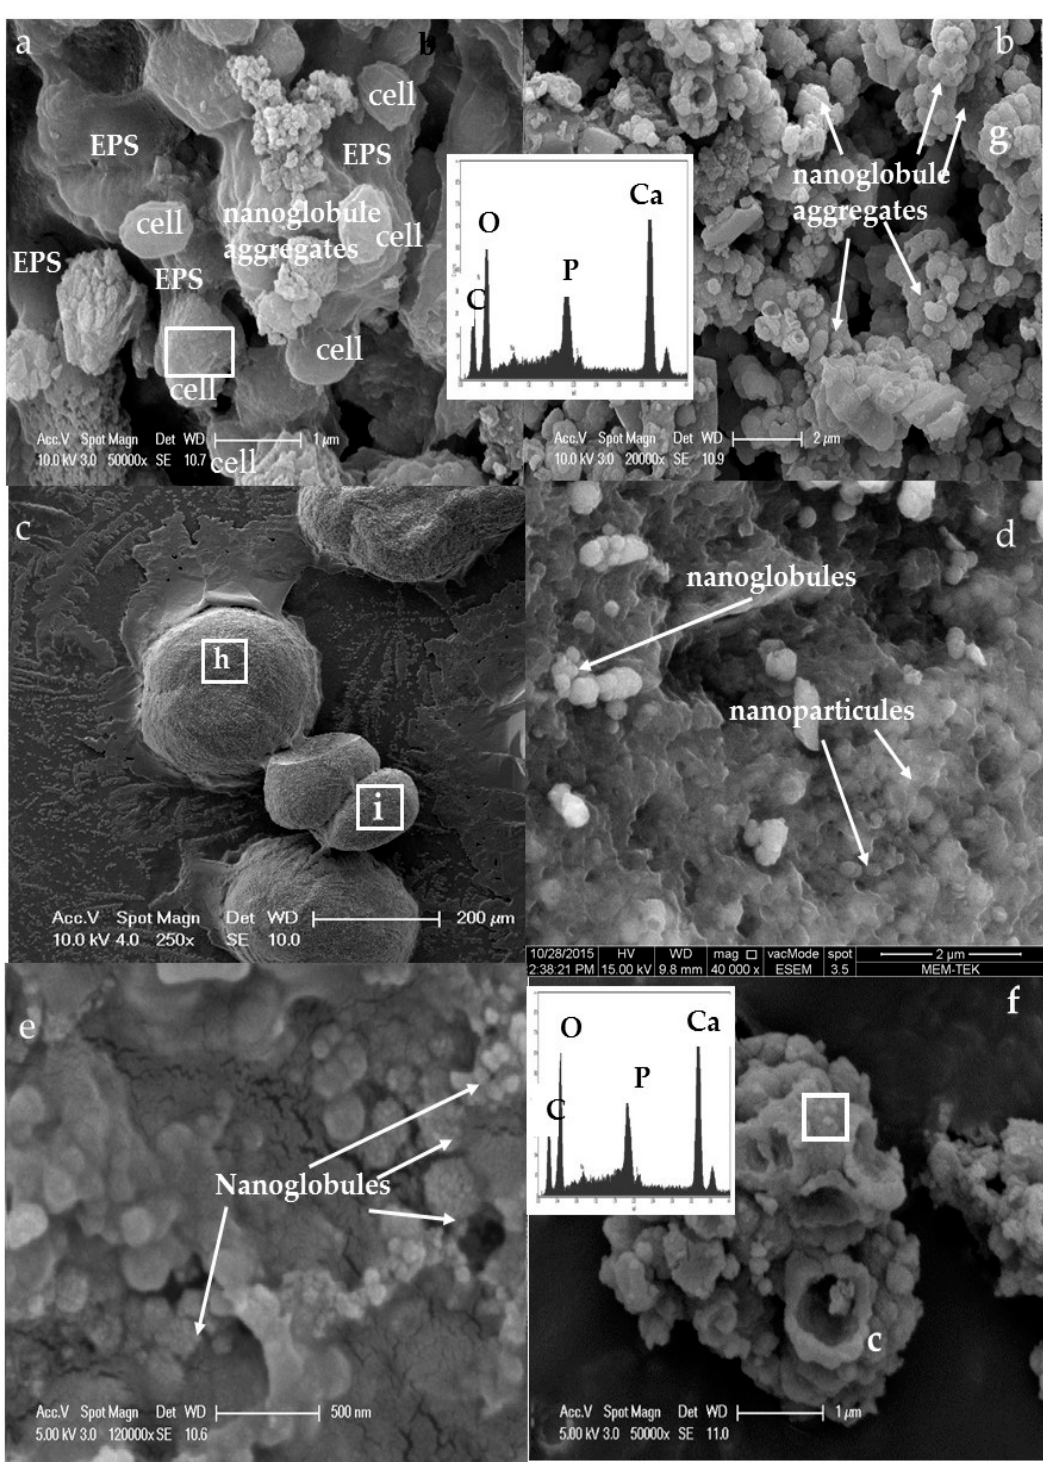
Figure 8. SEM photomicrographs and EDX spectra of carbonate bioliths formed during 10 days of incubation: ( a ) calcite with spiny surfaces and nanoglobule aggregates closely associated with EPS and the cells (M6 experiment); note the early stage of calcite crystal associated with the cell in the area squared; ( b ) nanoglobule aggregates with EDX (g); ( c ) spherulite and dumbbell (M6 experiment); ( d ) a closer view of the area h square in c, note the aggregated nanoparticles on the surface of calcite (M6 experiment); ( e ) a closer view of the area i square in c, note irregular size of nanoglobules on the surface of spherulite (i) in c; and ( f ) aggregated nanoglobules and mineralized bacteria with EDX spectra of the squared area.